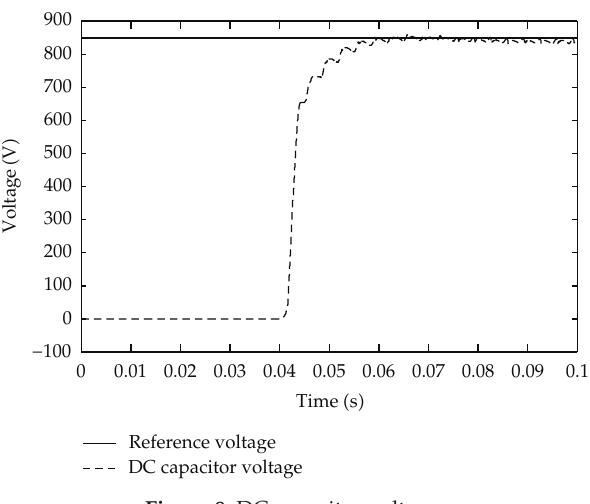
Figure 8: DC capacitor